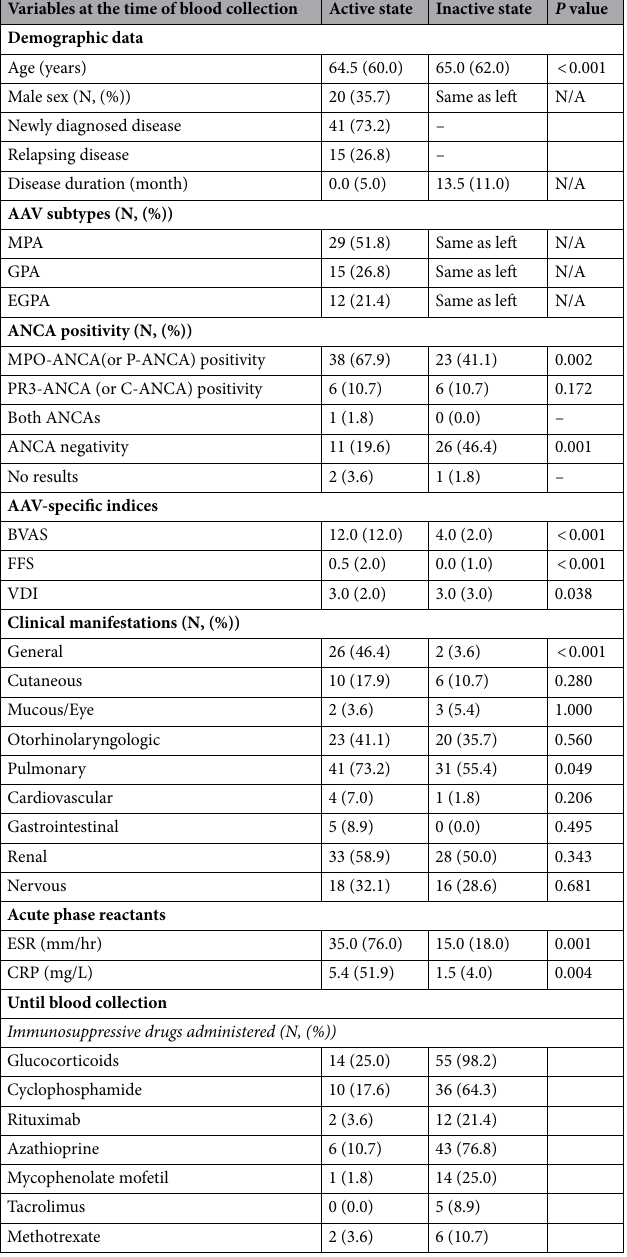
Table 1. Characteristics of 56 patients with active and inactive AAV (Paired analyses). Values are expressed as median (interquartile range (IQR)) or number (percentage). AAV ANCA-associated vasculitis,